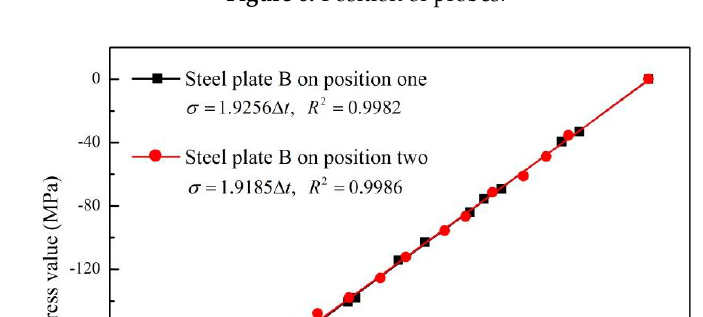
Figure 6. Position of probes.